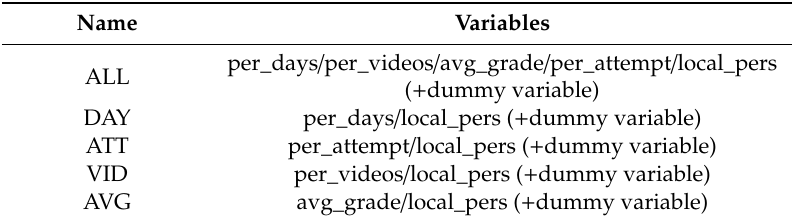
Table 5. Models used in the predictive analysis.